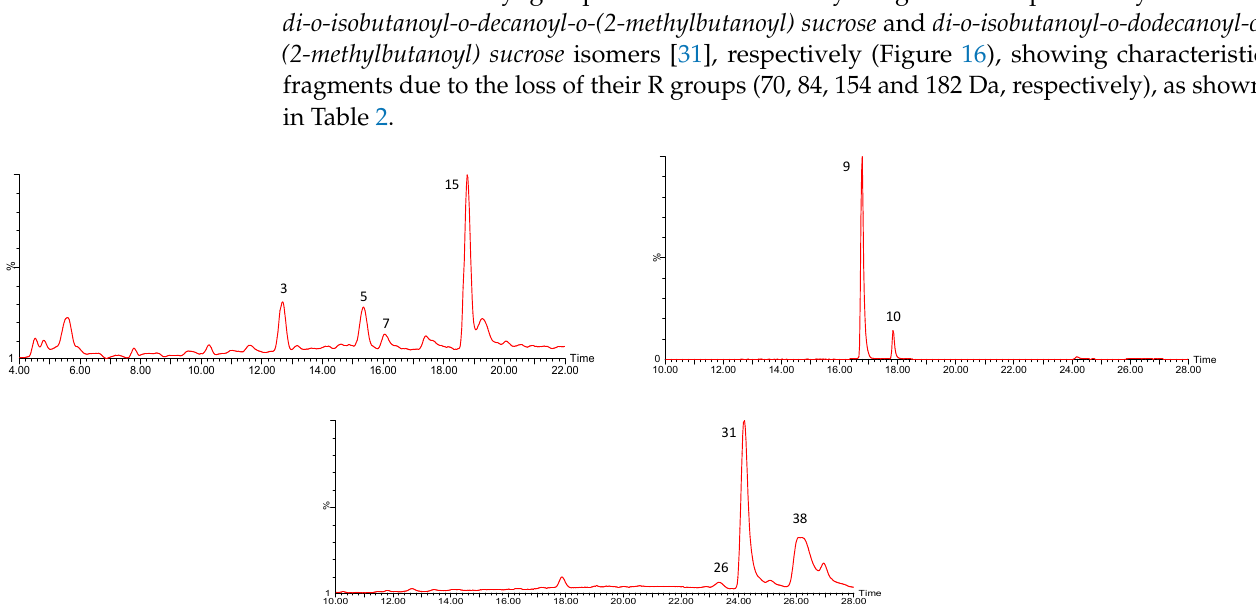
Table 3. UPLC-ESI-MS characterization of flavonoids in Physalis peruviana samples from Costa Ri- ca. Peak No.